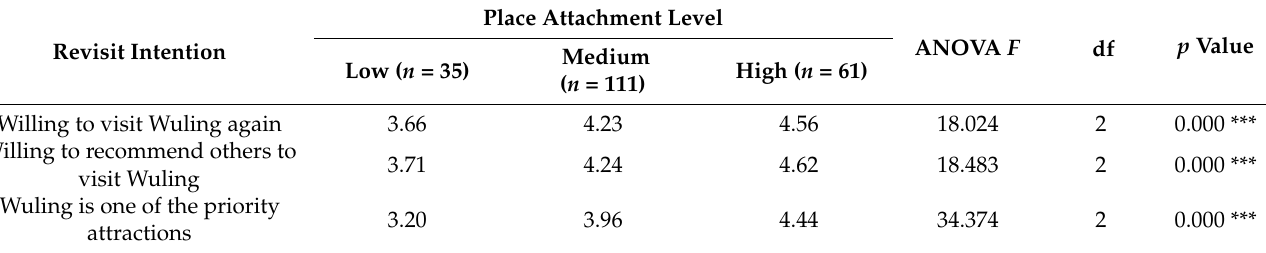
Table 9. Revisit intention based on place-attachment